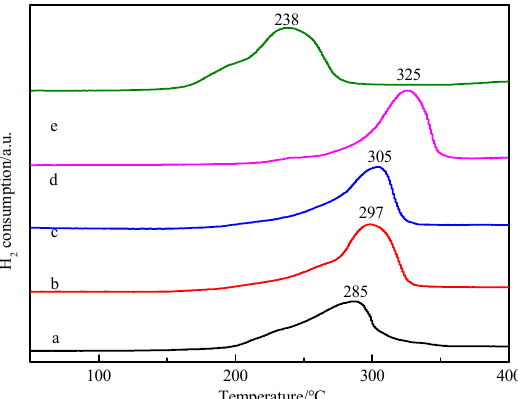
Figure 7. Temperature-programmed reduction (TPR) profiles of Cu 2 O and Cu x O-Fe y O z with di ff erent Fe / Cu ratios ( a ) Cu 2 O, ( b ) CF-0.05, ( c ) CF-0.1, ( d ) CF-0.8, and ( e )